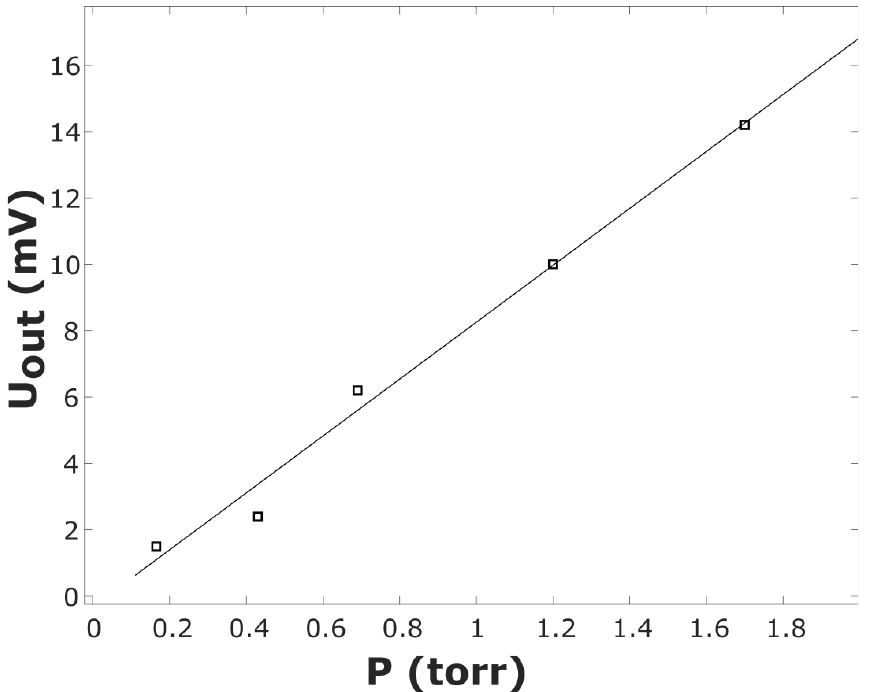
Figure 8. Output signal of the humidity sensor as a function of the vacuum meter readings during water vapor injection.